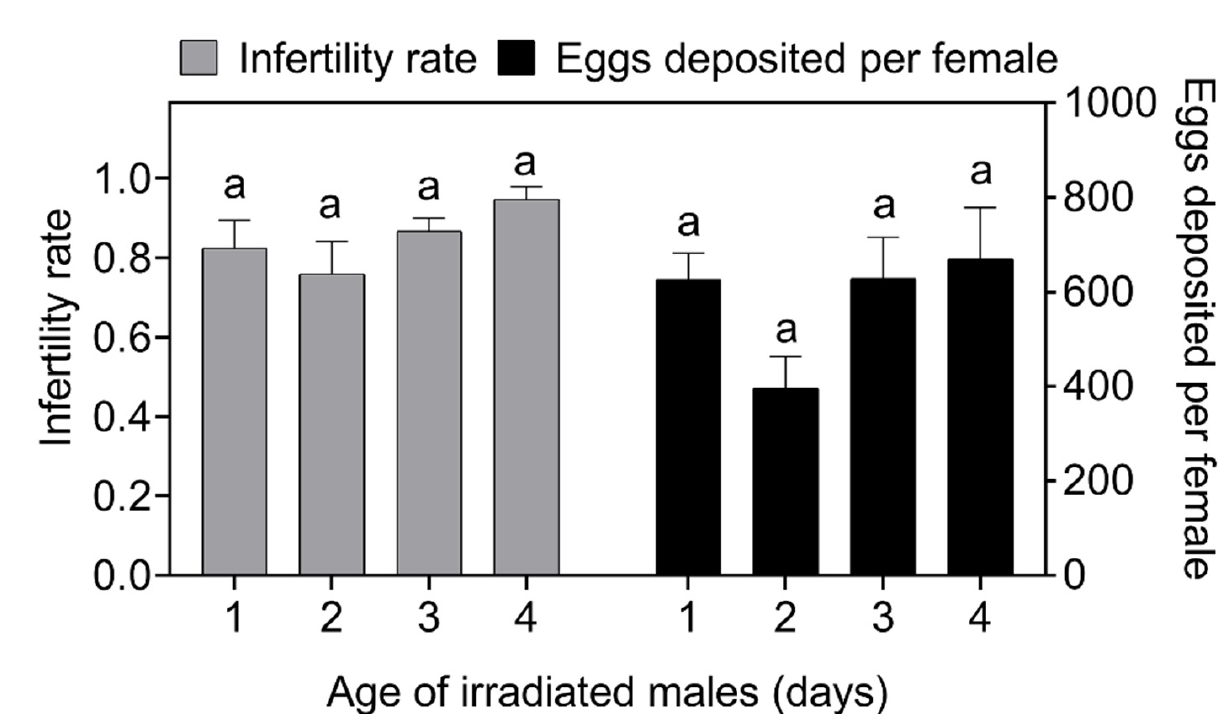
Figure 1. Average number of eggs laid per female ( A ), infertility rate (probability of non-hatching eggs) (mean ± standard error) and the fitting of the release ratio to the infertility rate (probability of non-hatching eggs) ( B ) in Spodoptera frugiperda at different release ratios; different lowercase letters indicate significant differences (one-way ANOVA, Tukey’s HSD; p < 0.05). T = treated with irradia- tion; N = not irradiated.